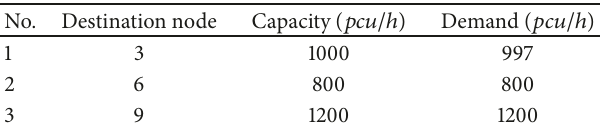
Table 11: Detailed information for shelterchoicein Case 1 when 𝜇 = 1.11 .